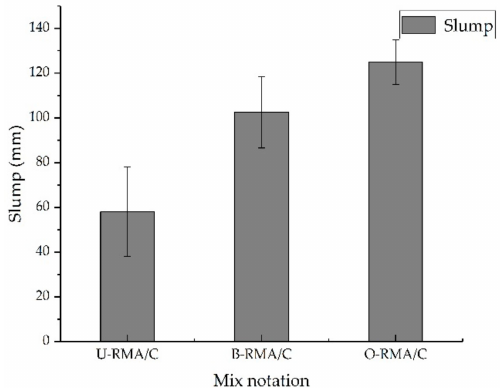
Figure 5. Slump of fresh concrete.